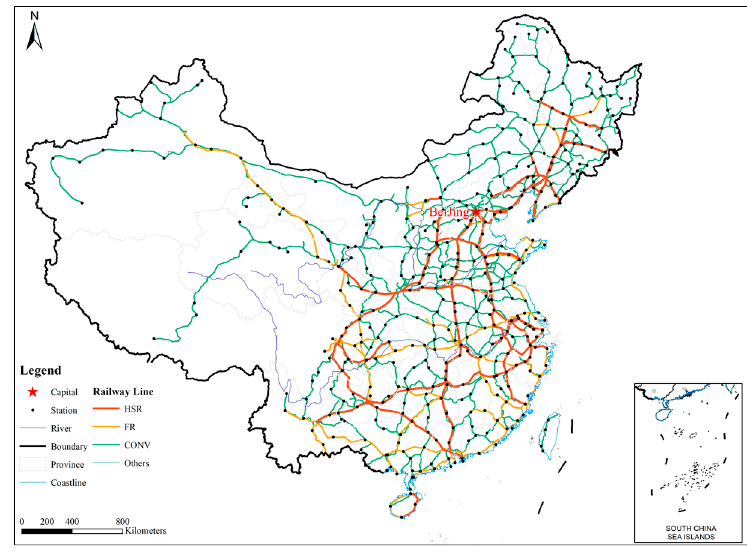
Figure 4. The geographic network.